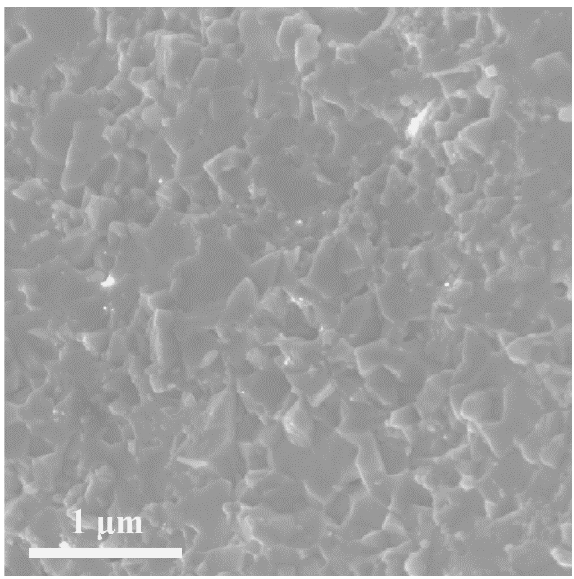
Figure 2. SEM image of hot pressed sample NbCo 1.3 Sb.